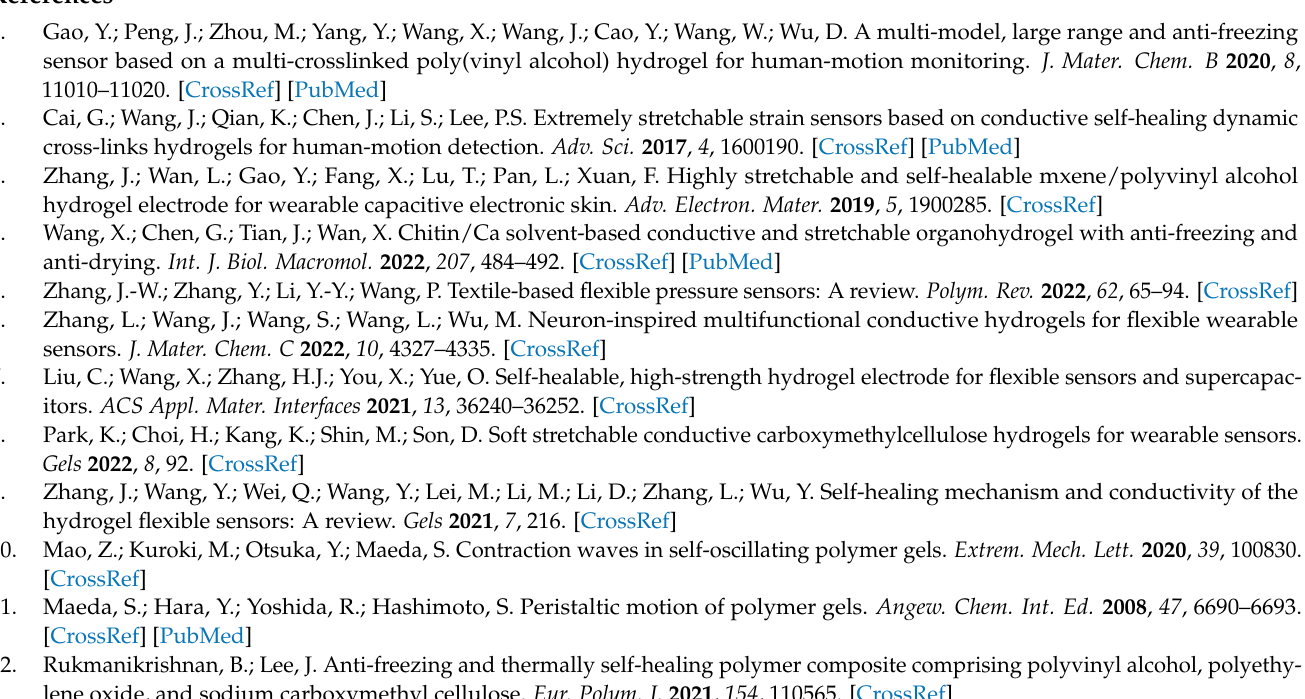
Figure S3: Pictures of the composite and DN hydrogels at − 20 ◦ C; Figure S4: (A) Stress–strain curves and detailed mechanical properties’ parameters of the composite hydrogel at different temperatures. (B) Tensile strength, (C) elastic modulus, and (D) elongation; Figure S5: GF variation of the DN hydrogel with strain; Figure S6: Circuit diagram of the lamp-lighting